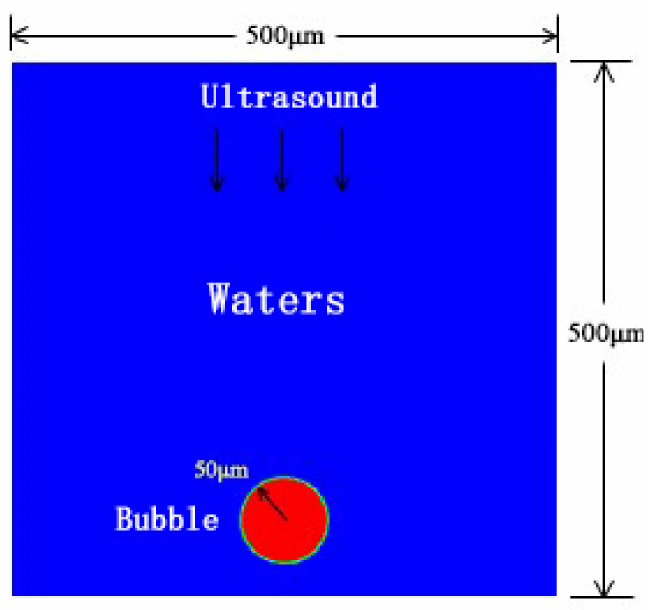
Figure 1. Simulation physical